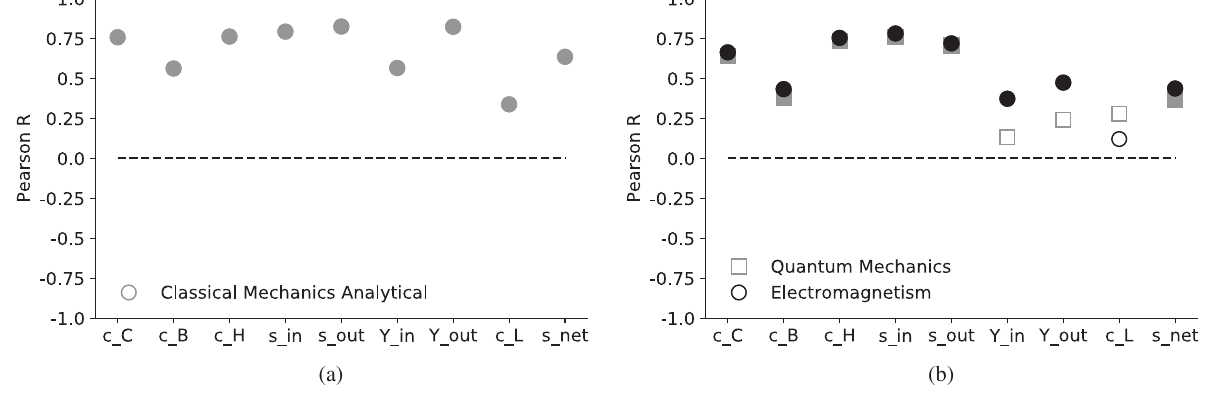
FIG. 4. Correlation of nodal centrality measures from the classical mechanics analytical network with (a) the corresponding nodal centrality measure from the classical mechanics numerical network, and (b) the corresponding nodal centrality measure from the other two courses: quantum mechanics, and electromagnetism. Filled markers indicate correlation coefficients that are statistically significantly different from a correlation coefficient of 0 (Holm-Bonferroni corrected p < 0 . 05 ). Statistical significance was determined using bootstrap resampling with 10 000 resamplings of each correlation